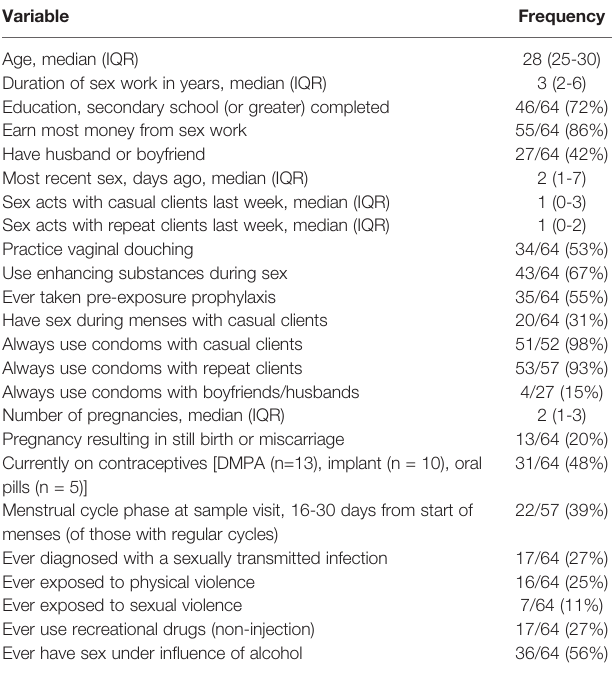
TABLE 1 | Behavioral, reproductive and demographic characteristics of study